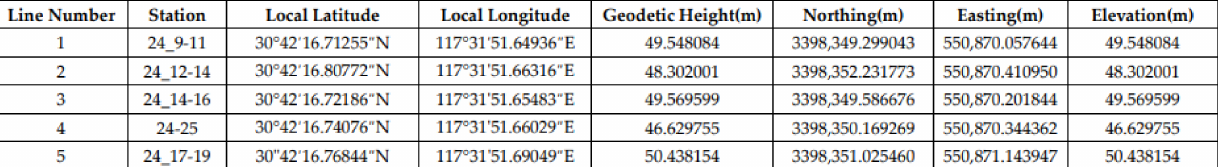
Figure 5. Single-point positioning solution coordinates.